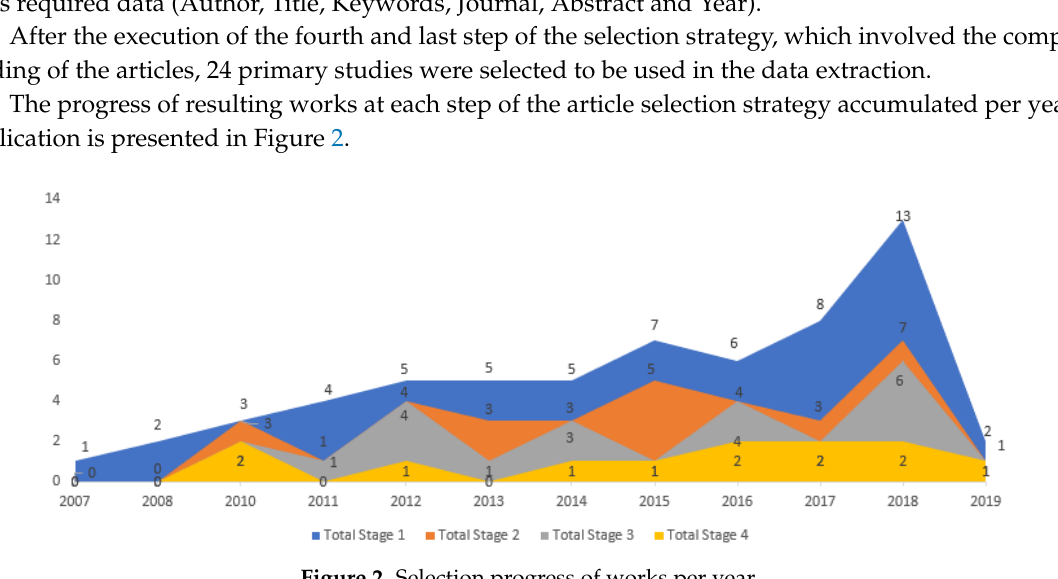
Figure 2. Selection progress of works per